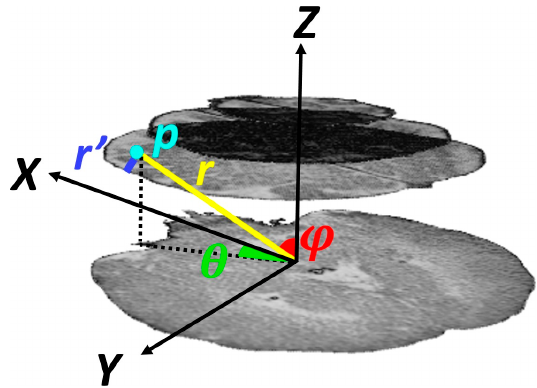
Figure 4. Illustration of location-based features of point p within the region of interest.